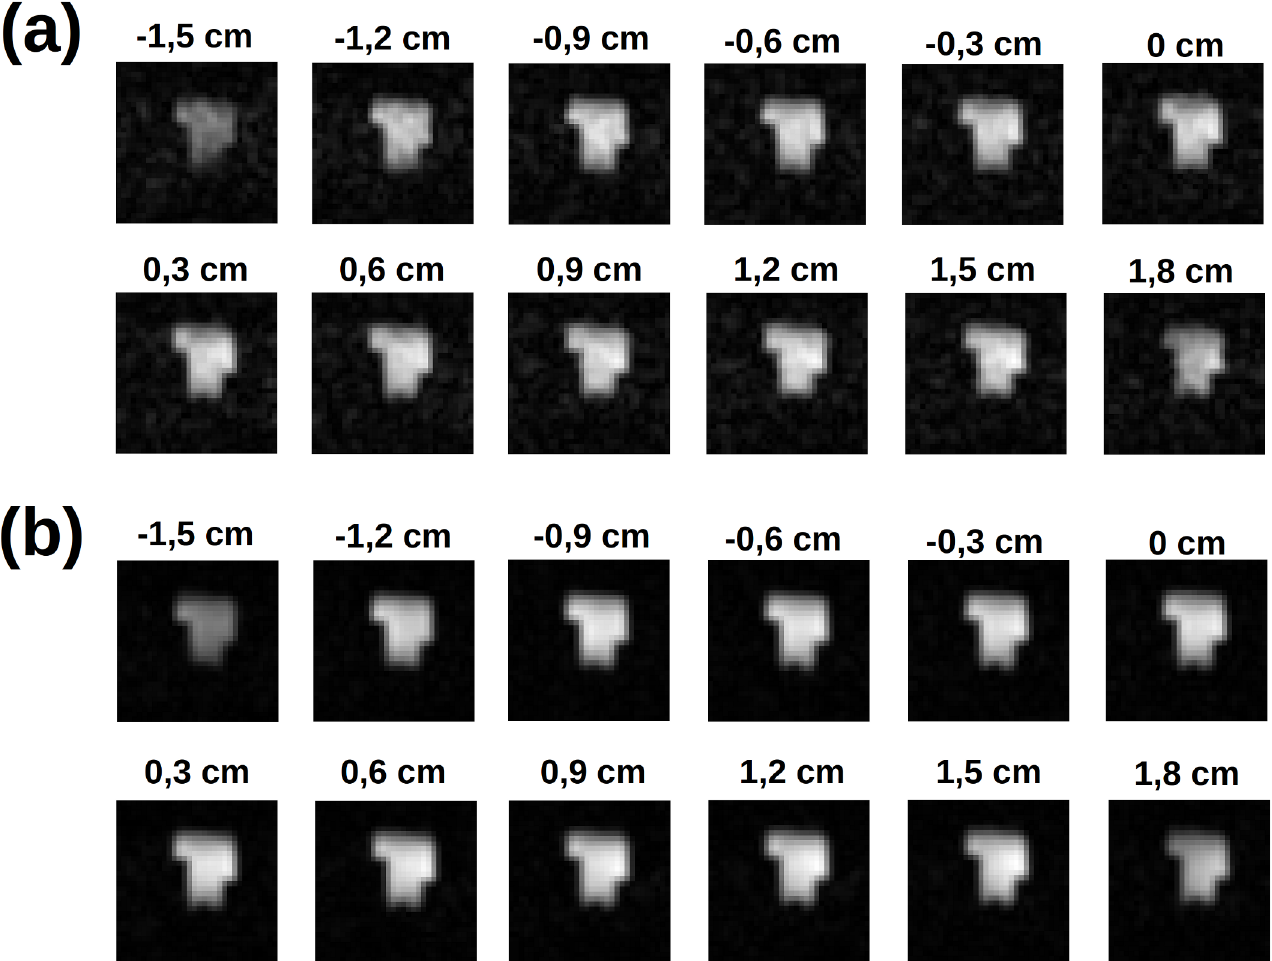
Fig 7. Slices from a 32 3 3D phantom acquisition at 3x3x3 mm 3 spatial resolution (spin echo, T E = 19 ms, T R = 500 ms, 32x32 phase encoding steps): (a) NEX = 1 for T acq = 8.5 min and (b) NEX = 9 for T acq = 77 min. The geometry of the phantom can be clearly detected through 3D